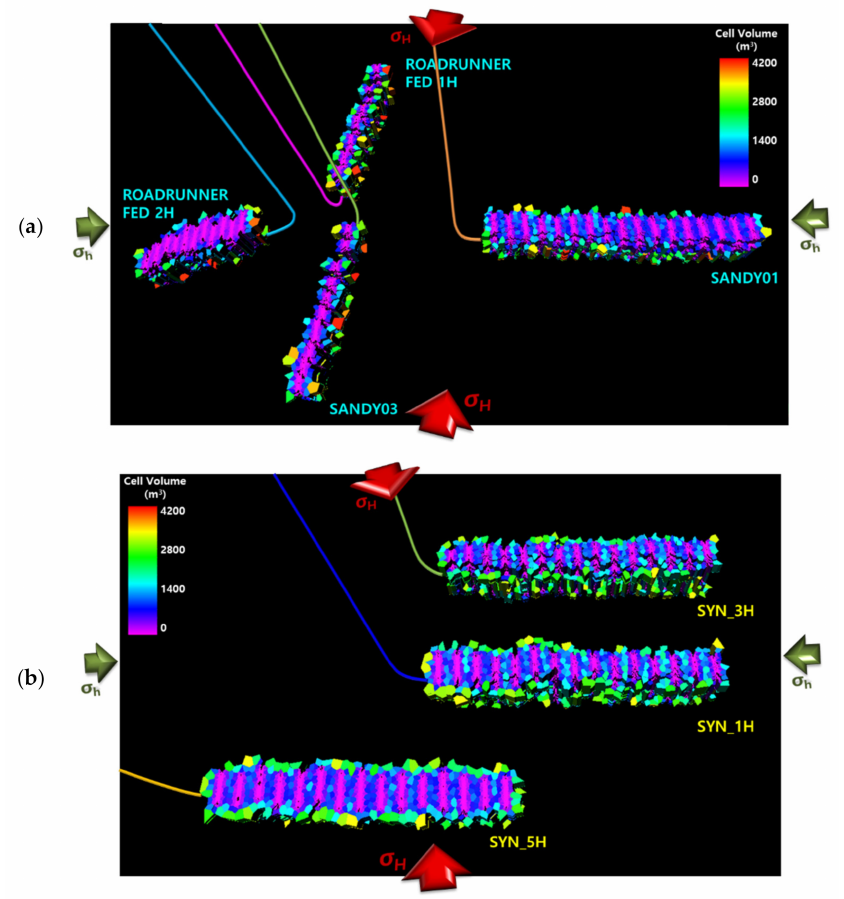
Figure 12. SRV of ( a ) “Actual Well Pattern” case and ( b ) “Proposed Well Pattern”